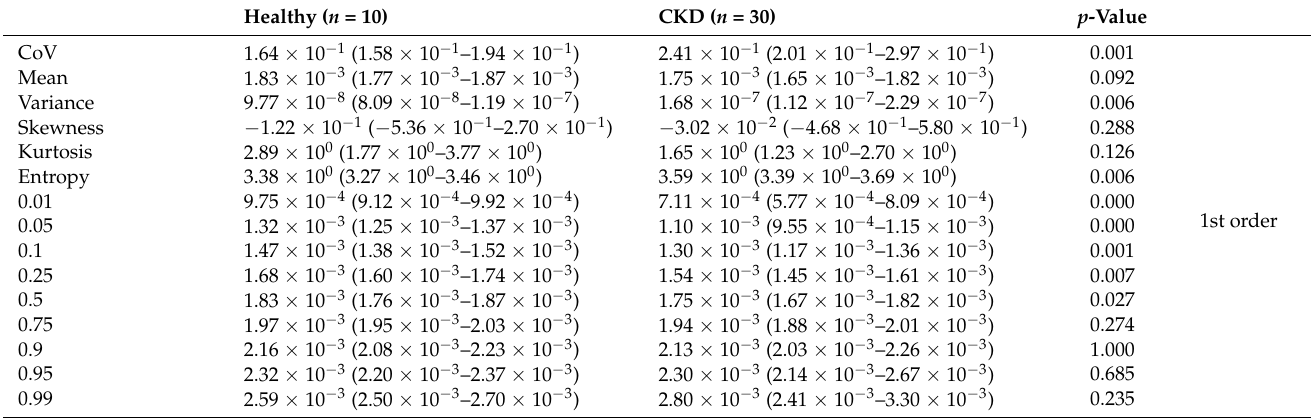
Table 2. Differences in radiomic features between two groups defined by eGFR.